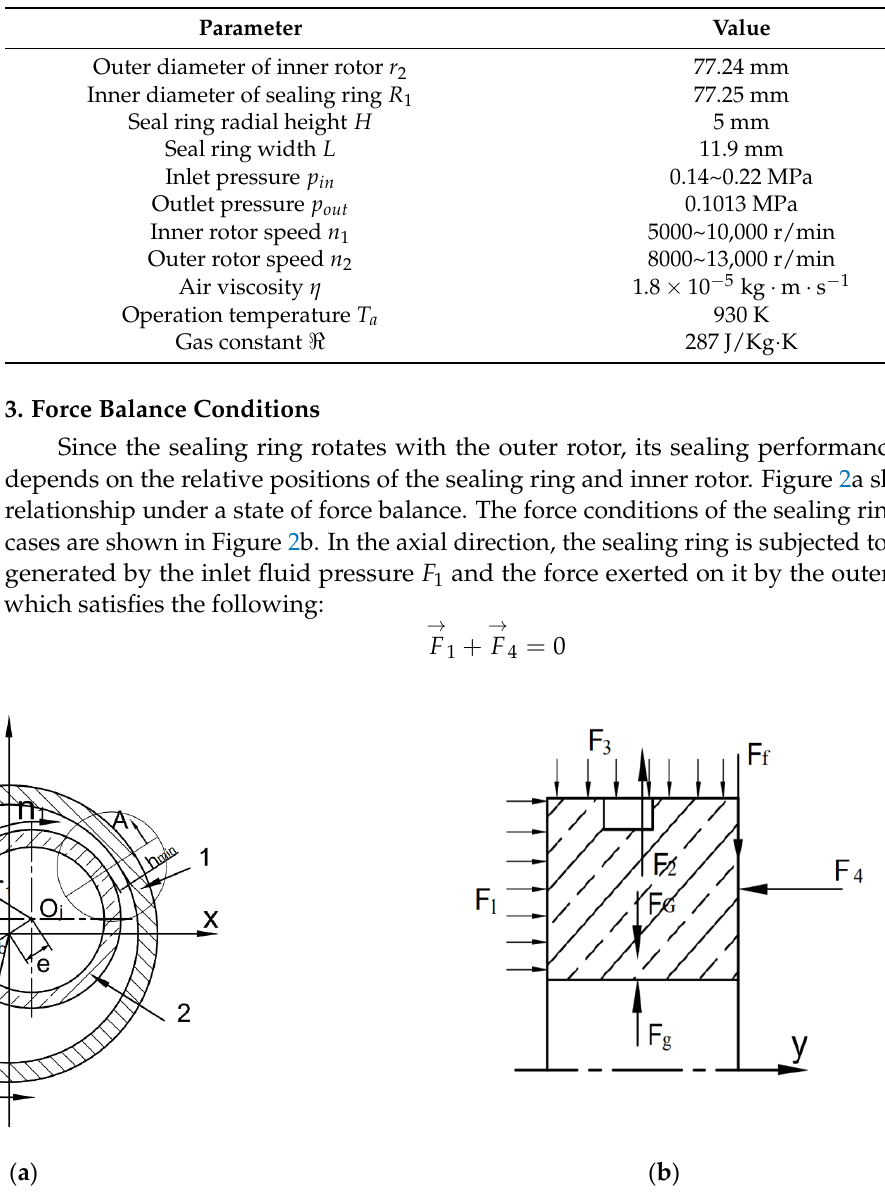
Table 1. Structural parameters and operating conditions of the seal.